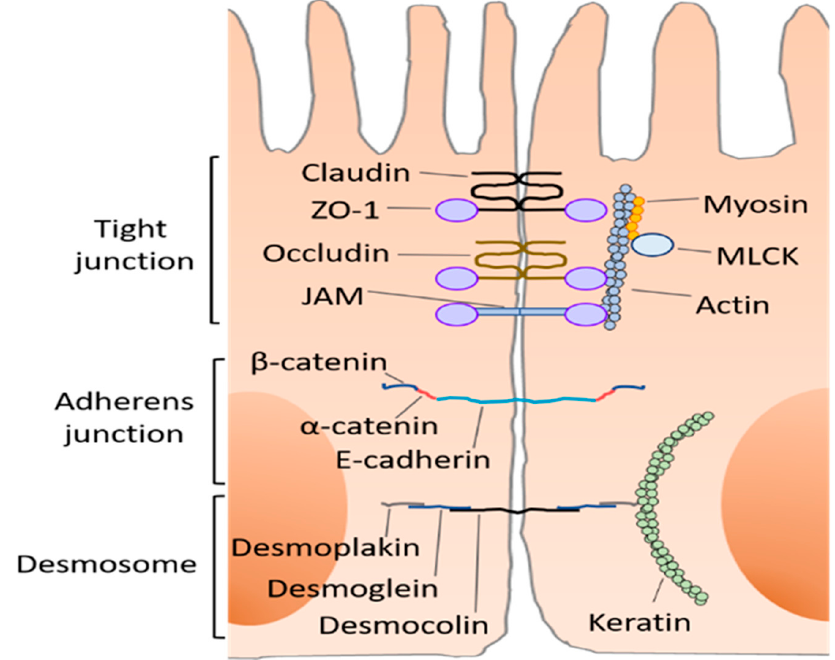
Figure 2. Construction of intestinal barrier. Epithelial cells bind each other with tight junction, adherens junction, and desmo- some. Tight junction consists of claudin, occluding, and junctional adhesion protein mol- ecule-A (JAM) recognized as a key construction which regulate the absorption of mole- cules via the paracellular route. These molecules, associated with zonula occluden-1 (ZO- 1), which contribute to the formation of tight junction as a scaffold protein. Myosin-actin complex which is associated with myosin light-chain kinase (MLCK) is also interacting with ZO-1 in a steady state. Adherens junction is comprised by α -catenin, β -catenin, and E-cadherin. Desmosome consists of three kinds of molecules with binding to keratin.